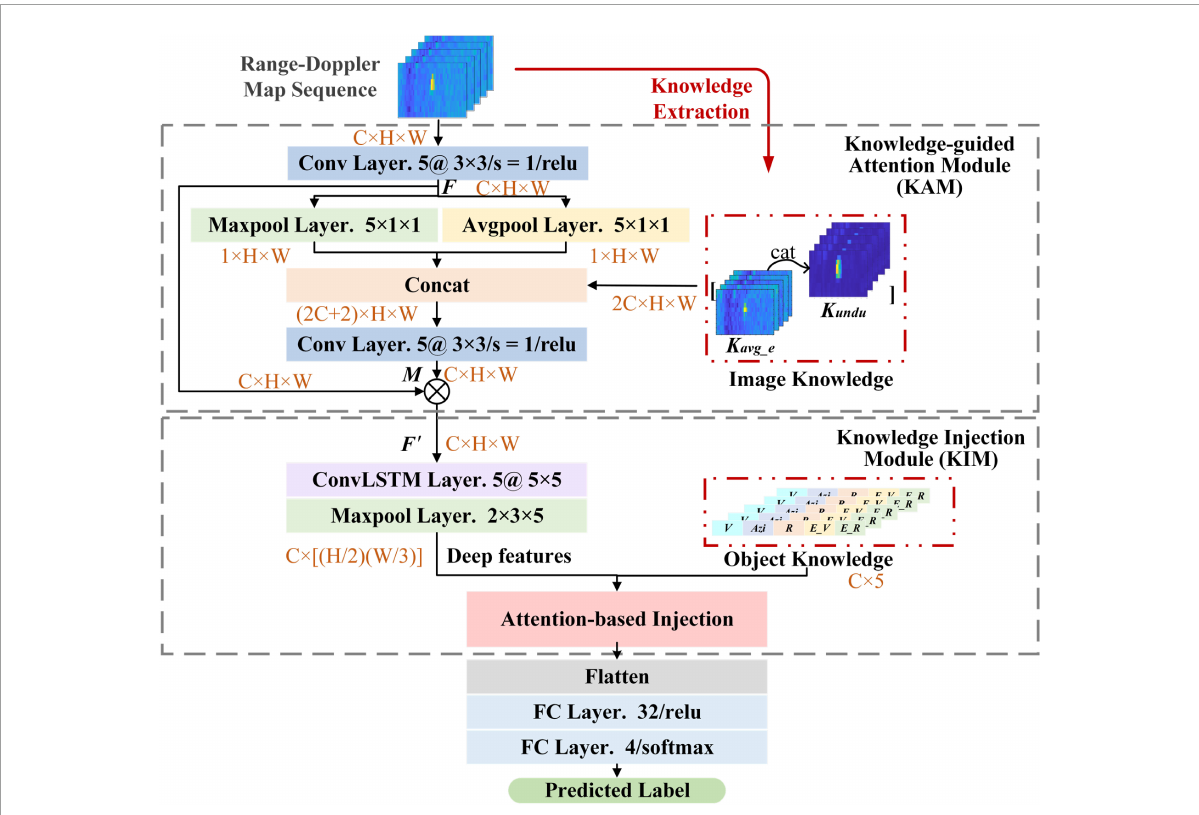
FIGURE1 Illustration of knowledge-assisted neural network (KANN). (C, H, and W denote the channel number, height, and width of the data; ⊗ represents Hadamard product).